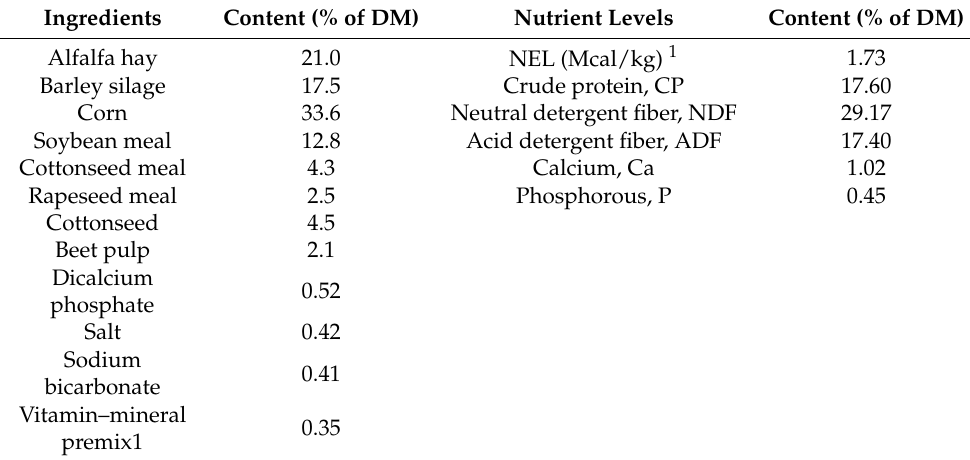
Table 2. Composition and nutrient levels of the basic